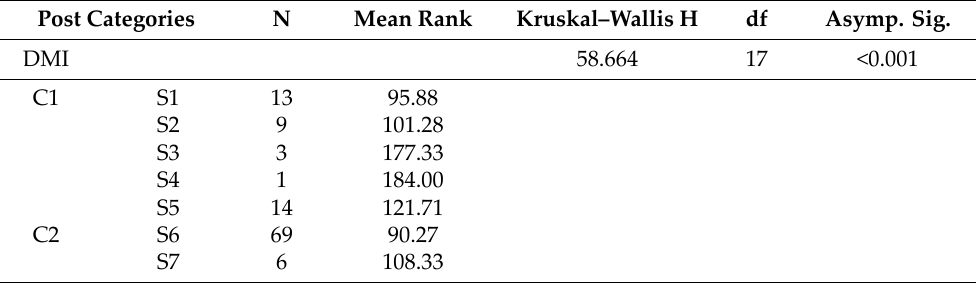
Table 7. Kruskal–Wallis Test results for video categories and